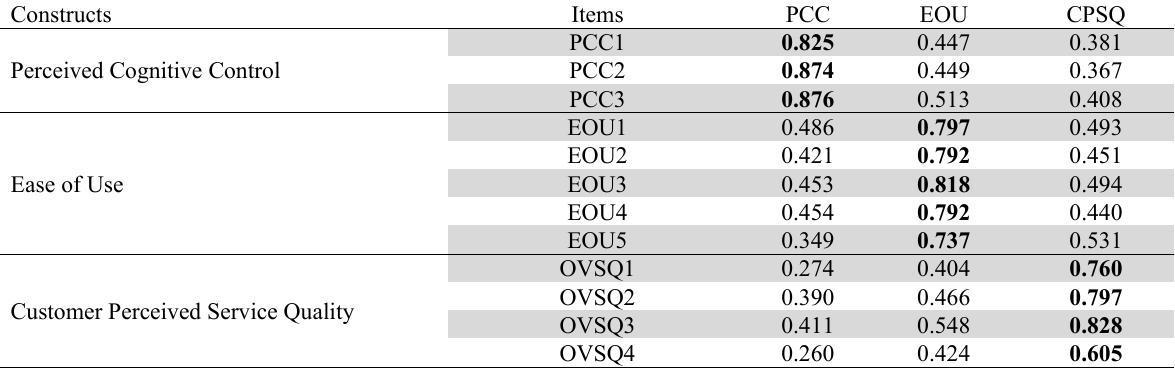
Significance Level of Factor Loadings Constructs